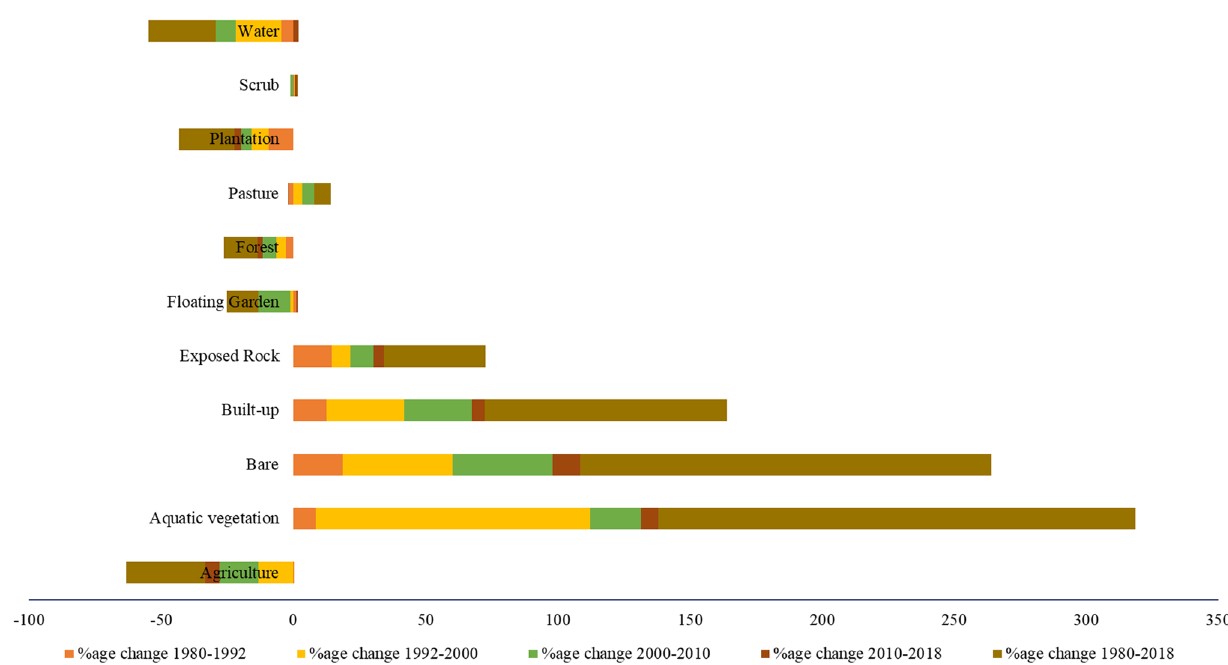
Fig. 8 Stacked bar chart showing how LULC categories have changed over last 04 decades in the Dal Lake watershed as percent